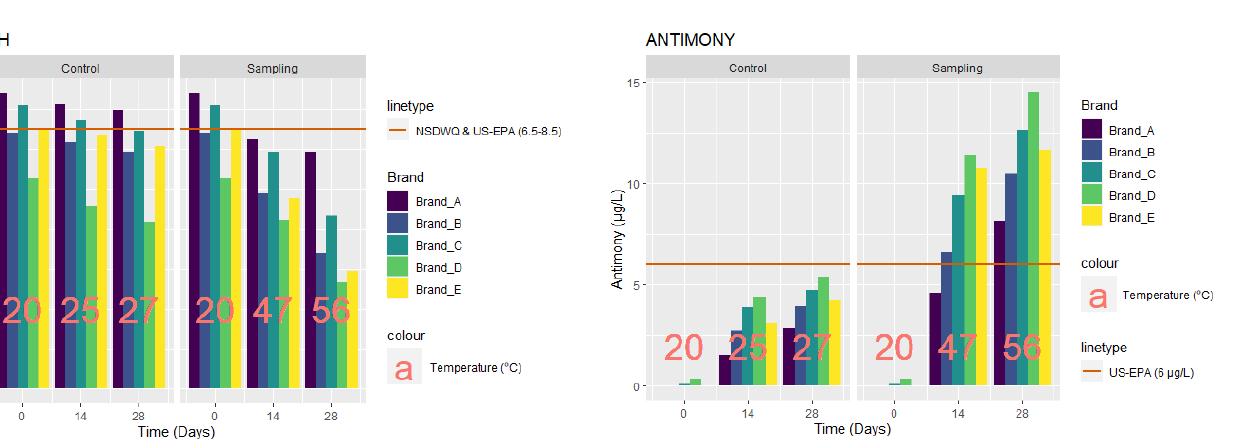
Figure 1. The pH values for the control group and sunlight expo- sure group.